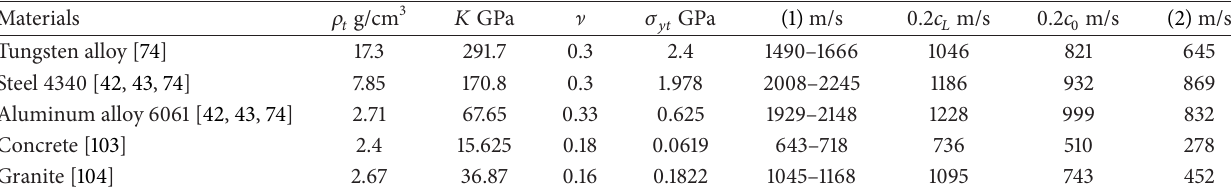
Table 2: The critical velocity ignoring the target material